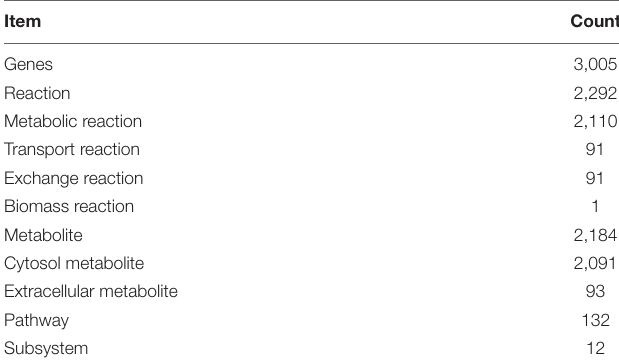
TABLE 3 | The characteristics of i